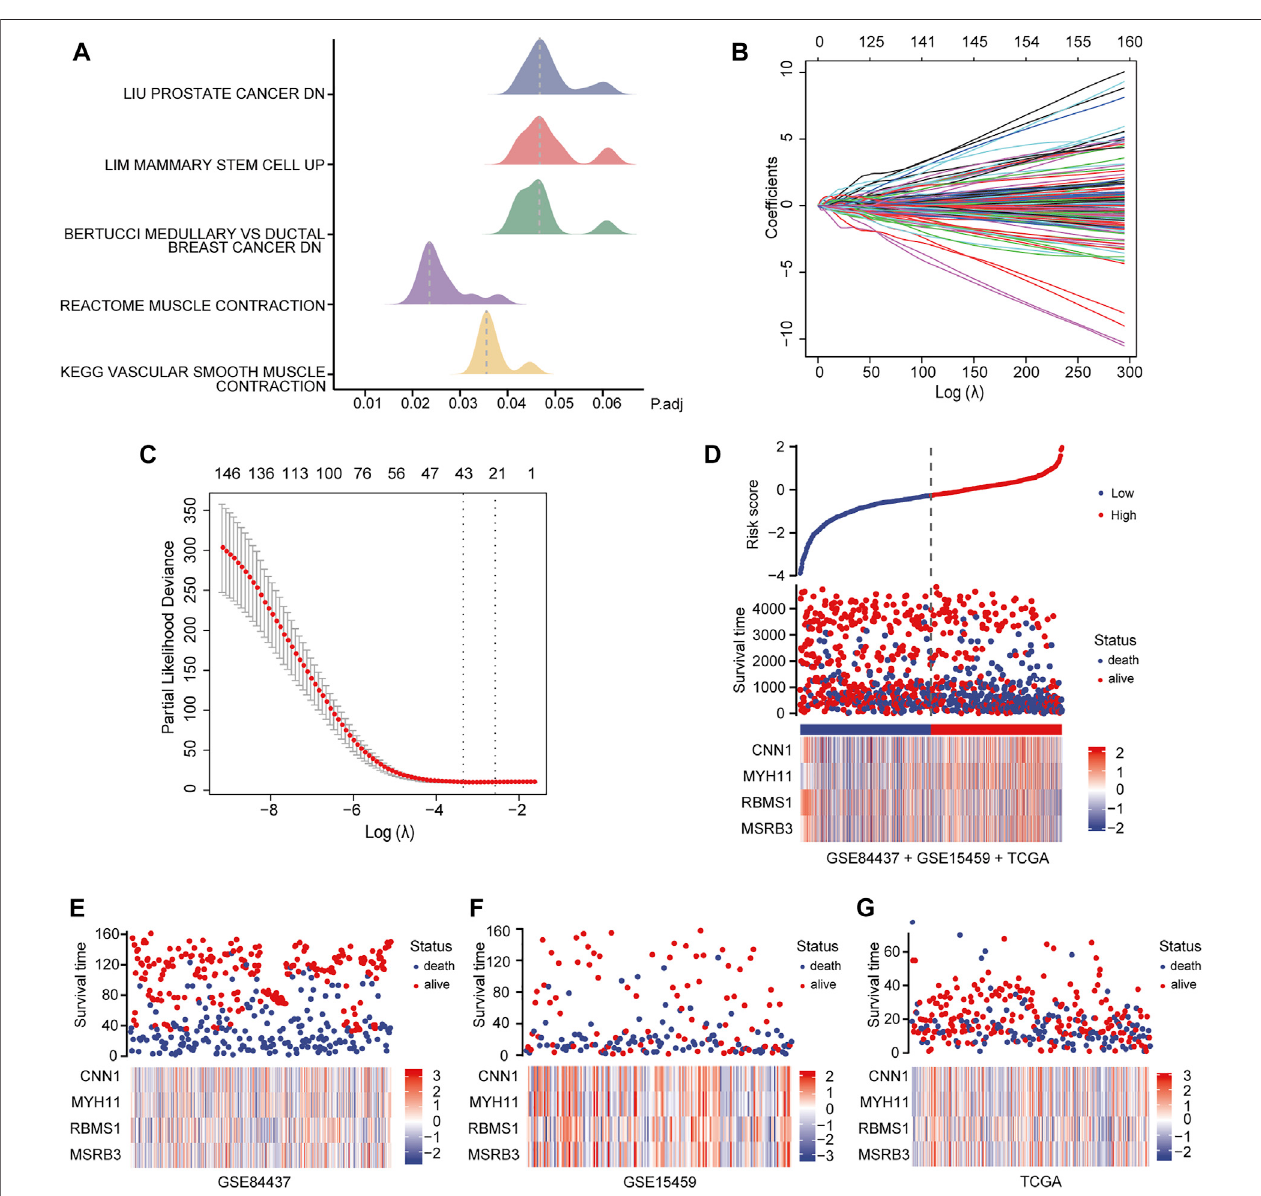
FIGURE 3 | Identi fi cation and analysis of prognostic genes. (A) GSEA of GC patients and non-GC patients. (B, C) LASSO regression analysis of 234 candidate genes. (D) Heat map showing the risk scores of the high and low-risk groups for the four prognostic genes in all three datasets. (E) Risk scores for the high and low-risk groupsforfourprognosticgenesintheGSE84437dataset. (F) Riskscoresforthehighandlow-riskgroupsforfourprognosticgenesintheGSE15459dataset. (G) Risk scores for the high and low-risk groups for four prognostic genes in the TCGA dataset.